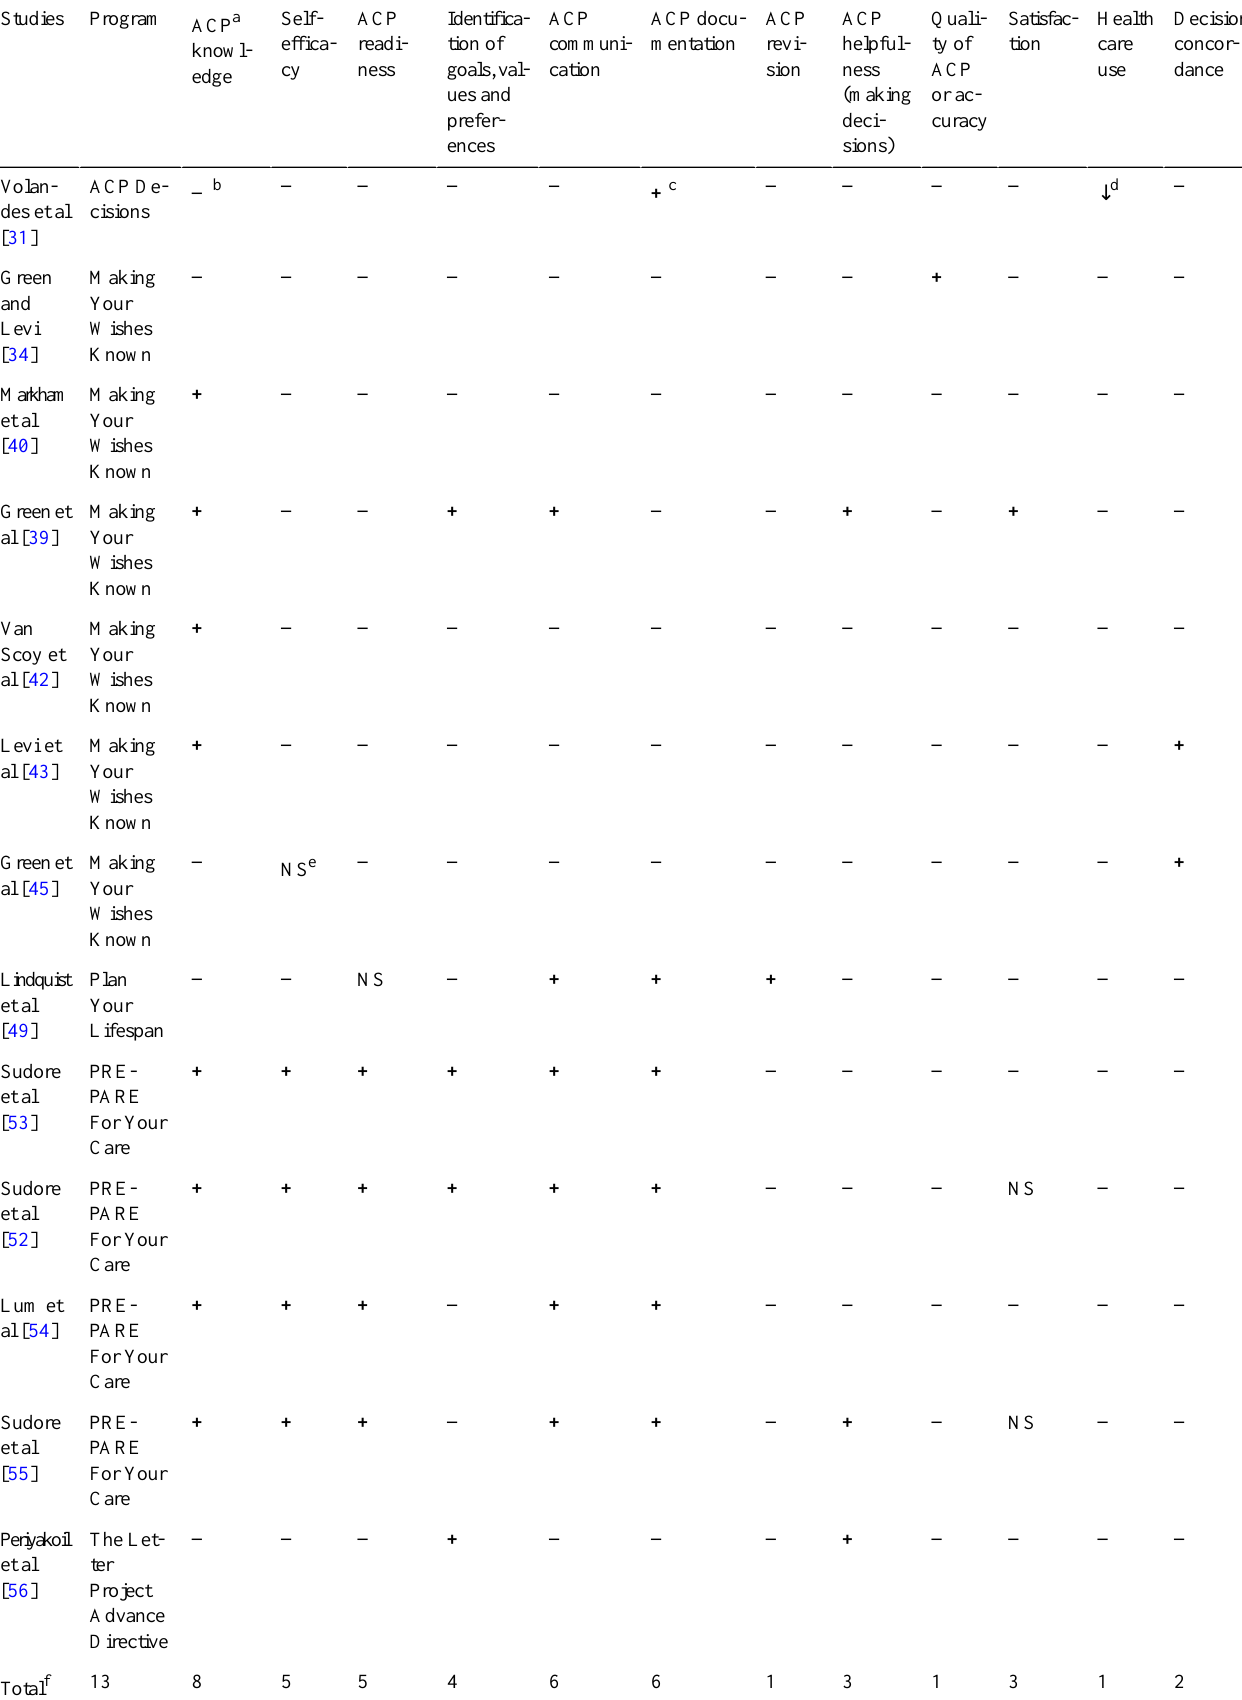
Table 3. Results of quantitative studies assessing the effectiveness of Web-based advance care planning programs comparing the intervention group (Web-based advance care planning program) with baseline and/or control